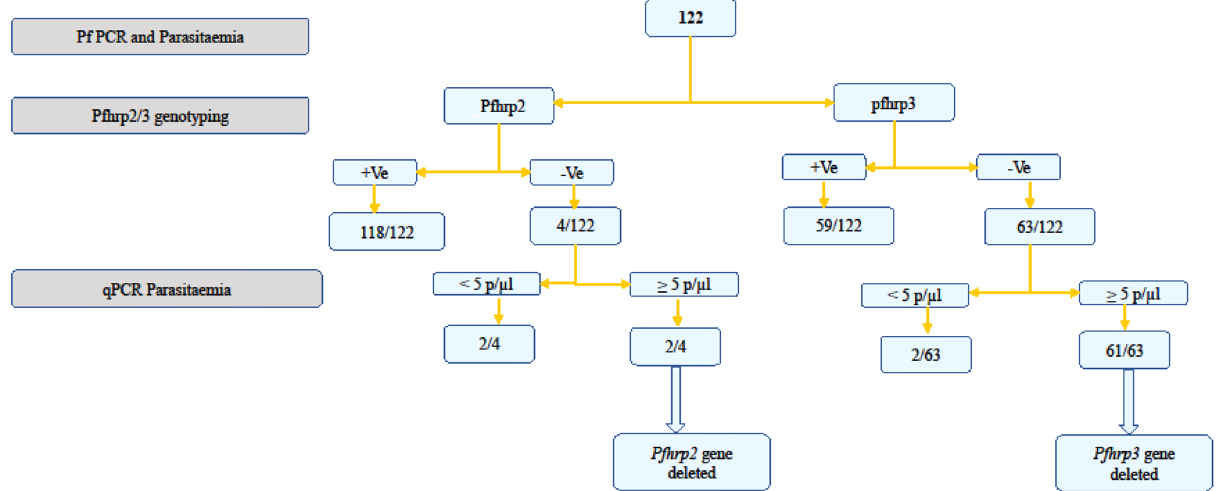
Figure 1. A flow chart showing analysis for determining pfhrp2/pfhrp3 gene